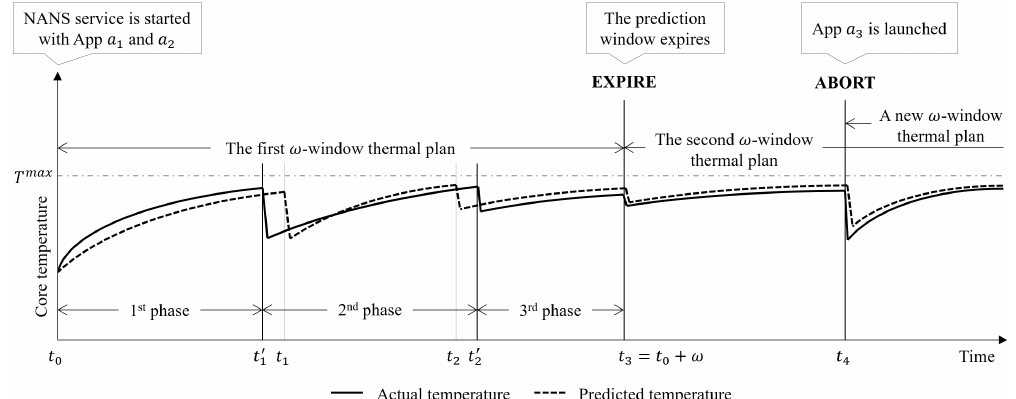
Figure 13. Overall process of thermal